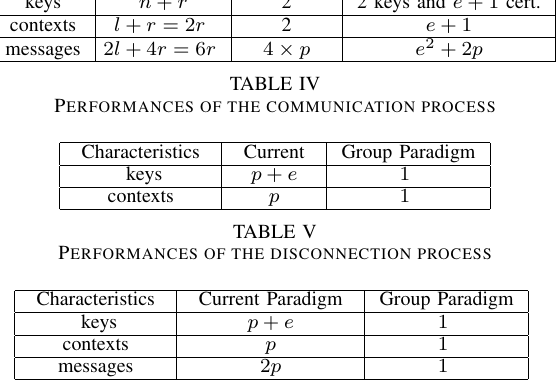
Fig. 6. Handover in the group paradigm (pess. and opt. cases) TABLE III P ERFORMANCES OF THE HANDOVER PROCESS Charact.